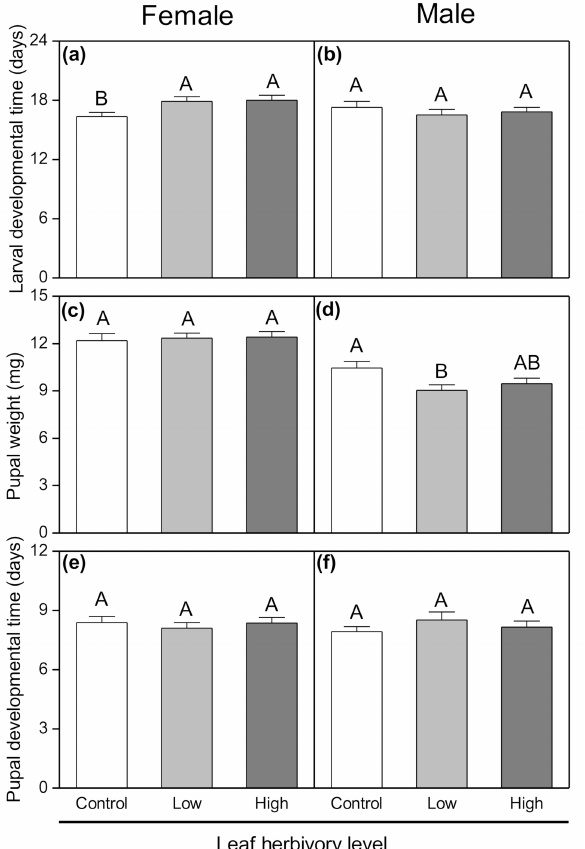
Figure 2. Changes in ( a , b ) larval developmental time, ( c , d ) pupal developmental time, and ( e , f ) pupal weight of female and male Phthorimaea operculella in tuber tissues for potato plants exposed to di ff erent herbivory levels of conspecific larvae. Data are means ± SE. Di ff erent letters indicate significant di ff erences among treatments ( p < 0.05) based on post hoc Tukey’s HSD